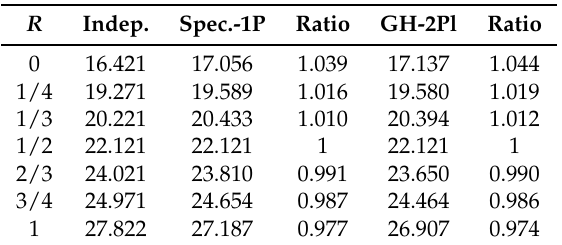
Table 12. Reversionary annuity price for the young generation under independence and using best-fit 1P, 2P